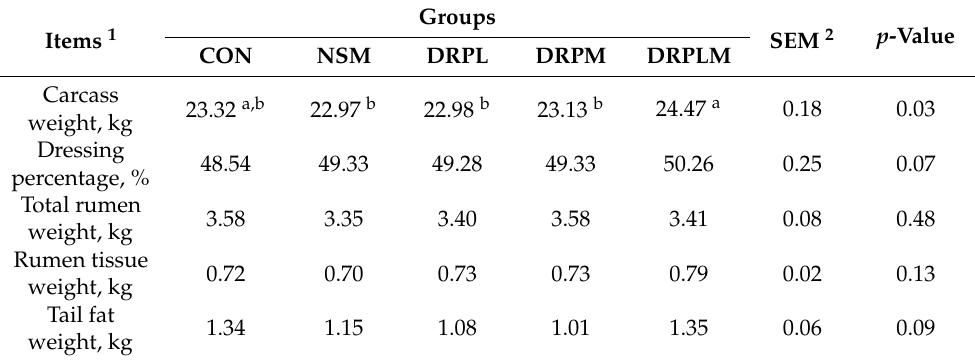
Table 3. Effects of dietary supplementation with rumen-protective amino acids on the carcass traits of Hu